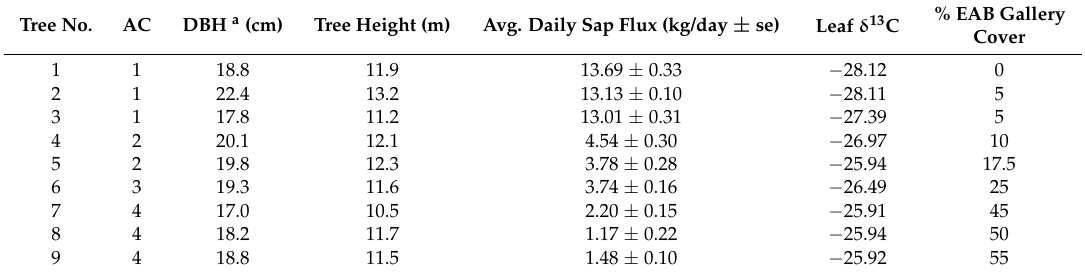
Table 1. Characteristics of the experimental Fraxinus pensylvanica sampled for sap flux density. Tree